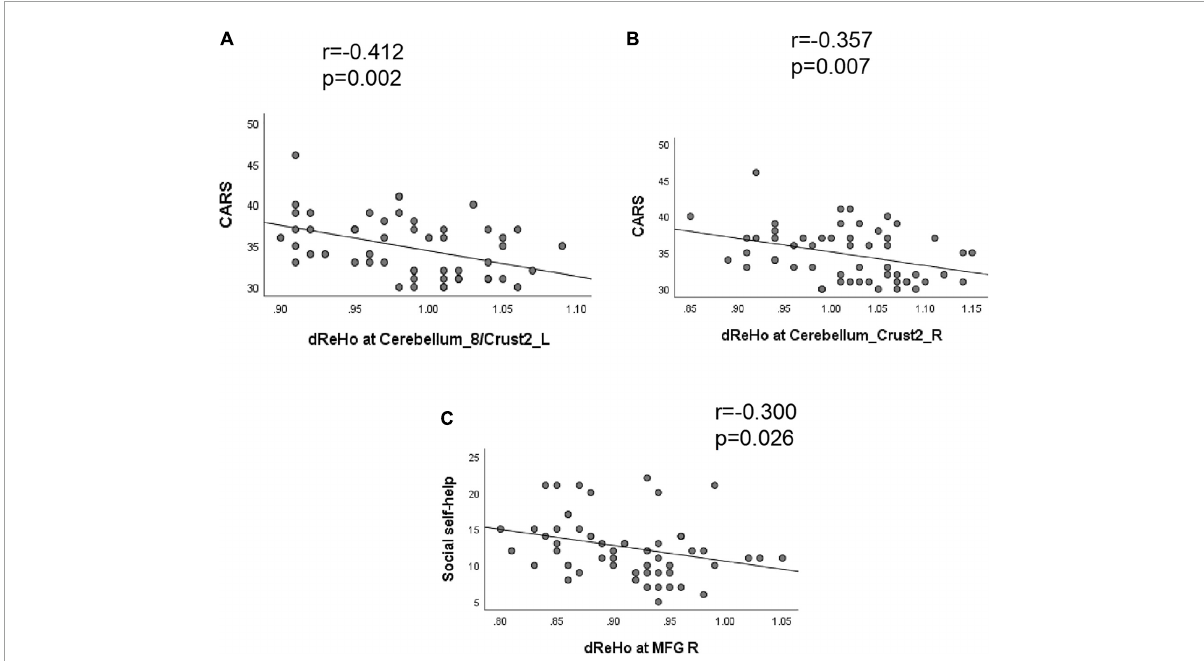
FIGURE3 Correlation between dReHo value and behavioral scores (ABC/CARS) in autism spectrum disorder (ASD) group. (A) The CARS score was negatively correlated with the dReHo of the left cerebellum_8/crust2 ( r = –0.412, P = 0.002). (B) The CARS score was negatively correlated with the dReHo of the right cerebellum_crust2 ( r = –0.357, P = 0.007). (C) The dReHo value of the right MFG were negatively correlated with the social self-help of the ABC score ( r = –0.300, P =